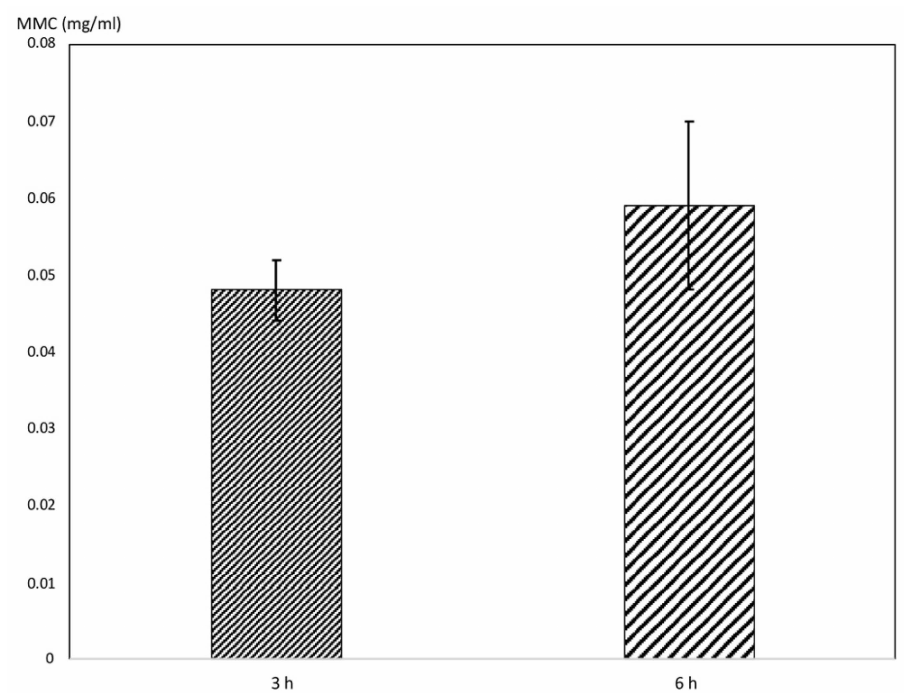
Figure 2. Concentration of MMC (mg/mL) released by BraidStent-SF-MMC at 3 h and 6 h. No significance found between the two groups (Student’s